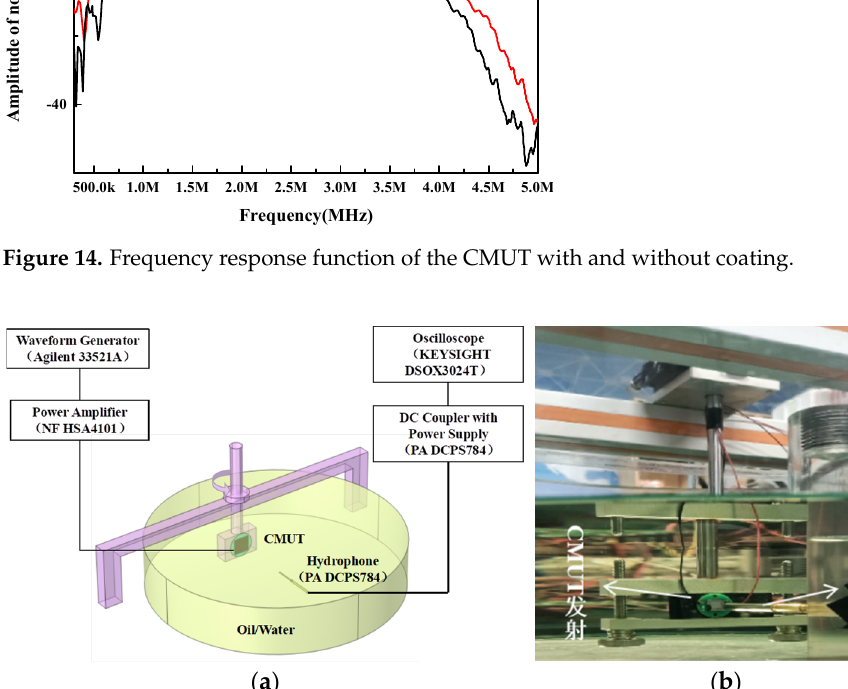
Figure 15. ( a ) Schematic of measurement setup of the CMUT transmitting directivity; ( b ) Photograph of the measurement setup, (left) transmission of CMUT, (right) receiving of the